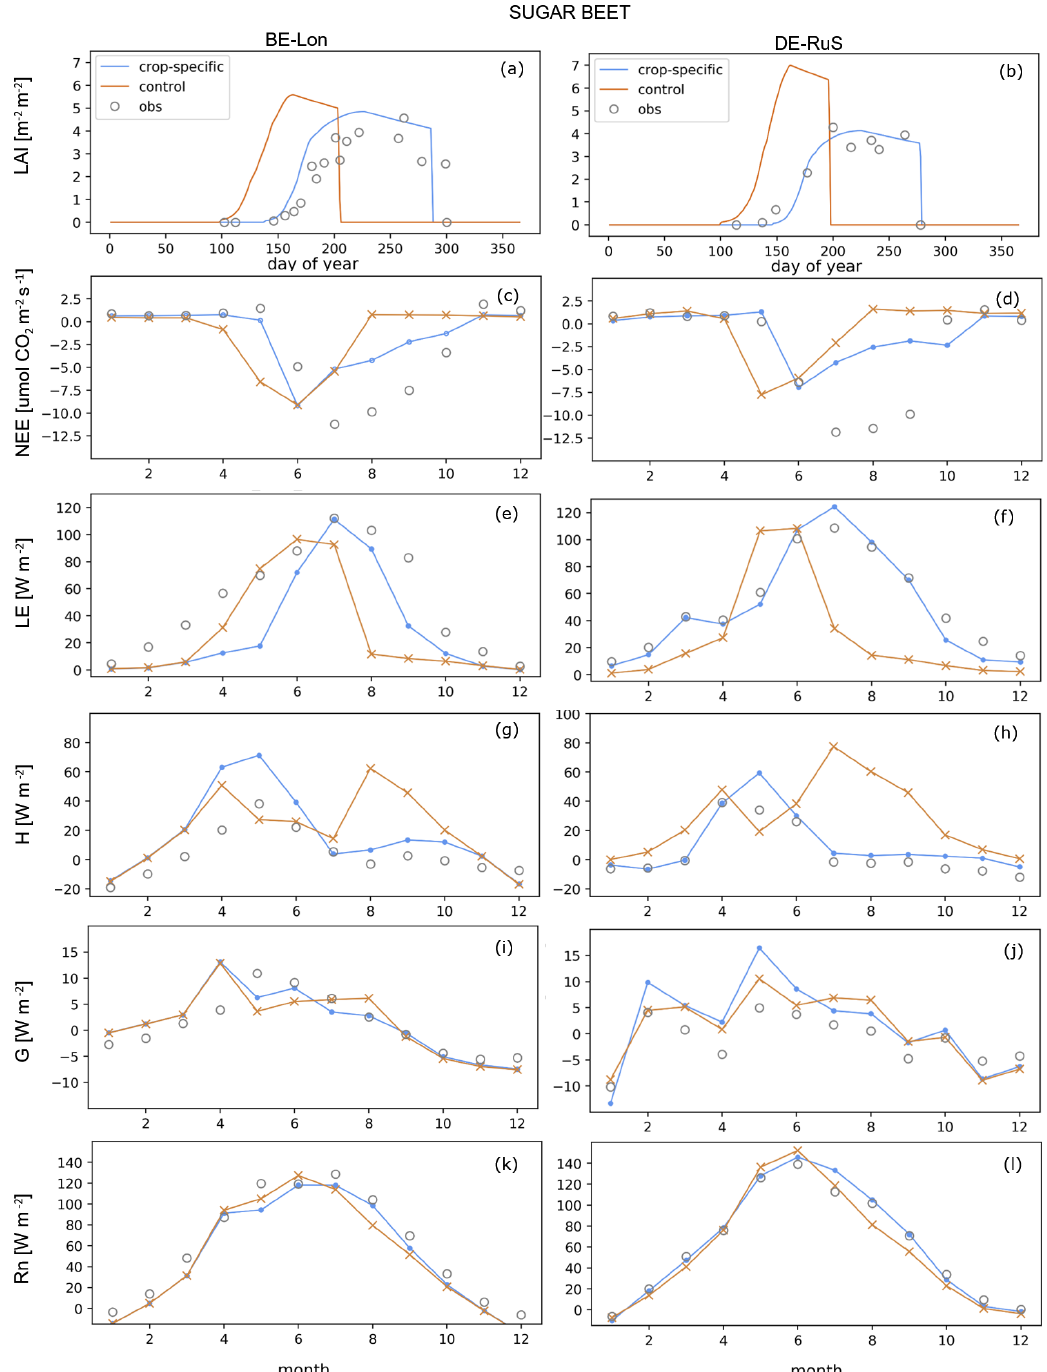
Figure 5. Simulation results of (a–b) LAI, and monthly averaged simulation results of (c–d) NEE, (e–f) LE, (g–h) H , (i–j) G , and (k–l) Rn for all sugar beet years (see Table 5) at the sites (left) BE-Lon and (right) DE-RuS. Simulation results for the control run (orange) and the crop-specific parameter set (blue) are compared to available site observations (grey) of LAI (all available point observations plotted) and fluxes (averaged over all respective years). Corresponding performance statistics for daily simulation results are listed in Table